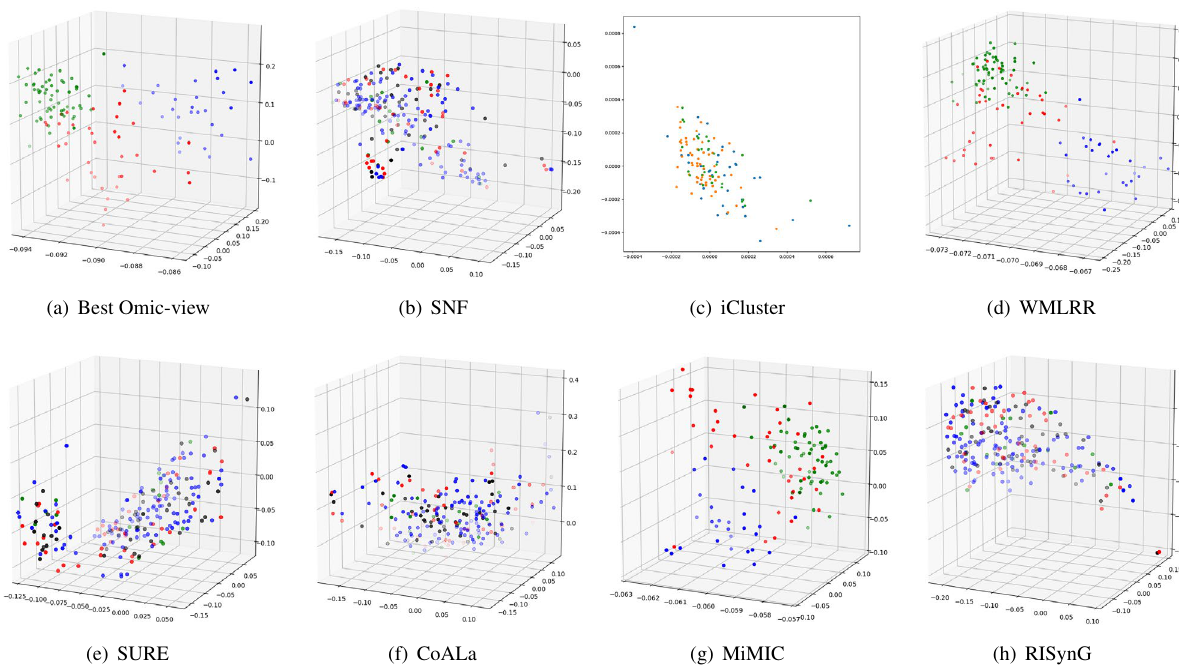
Figure 3. Comparative analysis of different integrative sub-spaces for CESC dataset.